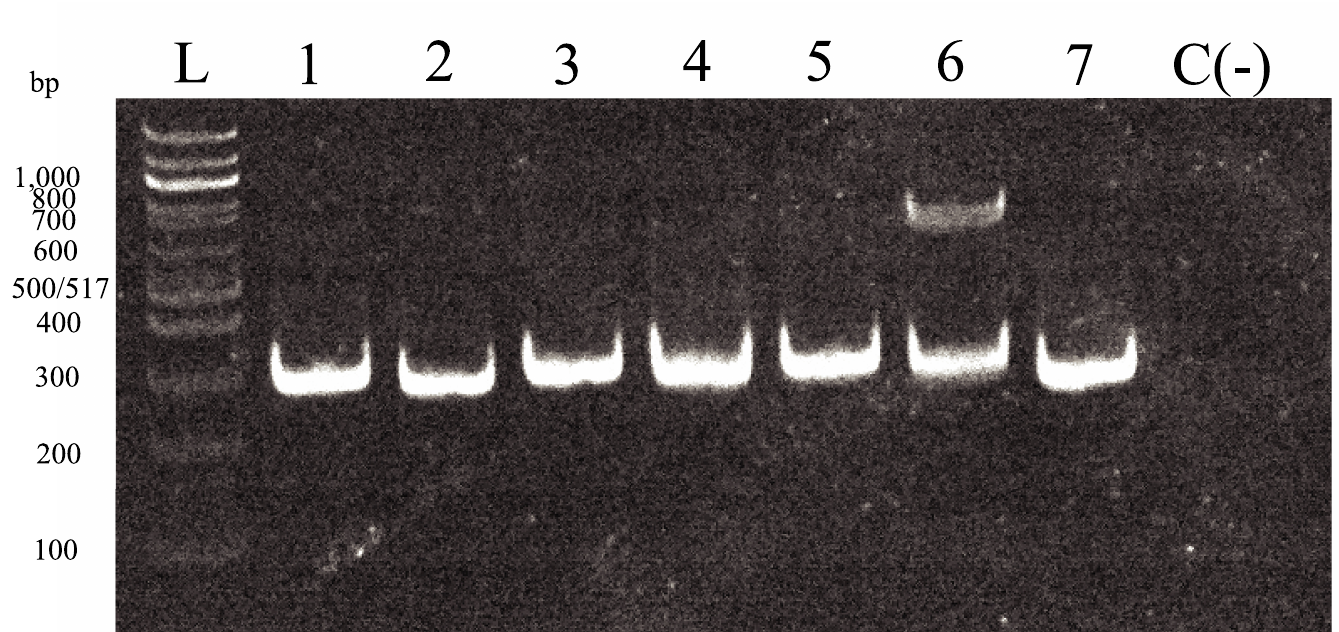
Fig 3. AFLP-PCR of TcCLB.506575.9 MM. Lane number: (1) strain EV-13C (DTU I), 377 bp amplicon; (2) strain CA-1-05 (DTU I), 377 bp amplicon; (3) strain CBBcl3 (DTU II), 397 bp amplicon; (4) strain ESMcl3Z2 (DTU II), 397 bp amplicon; (5) strain CANIII (DTU IV), 397 bp amplicon; (6) strain PSC-O (DTU V), 405 & 850 bp amplicons; (7) strain Tulacl2 (DTU VI), 383 bp amplicon. DNA ladder (L) (NEBioLabs, #N0551S).